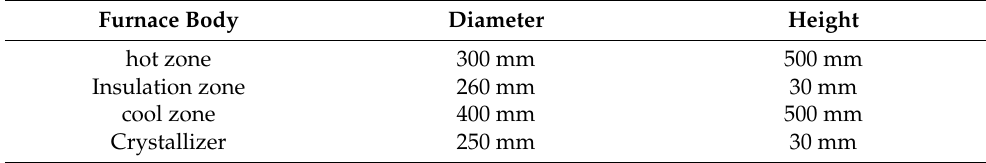
Figure 4. The casting system: ( a ) three-dimensional model; ( b ) grid model. Table 1. Dimensions of directional solidification furnace